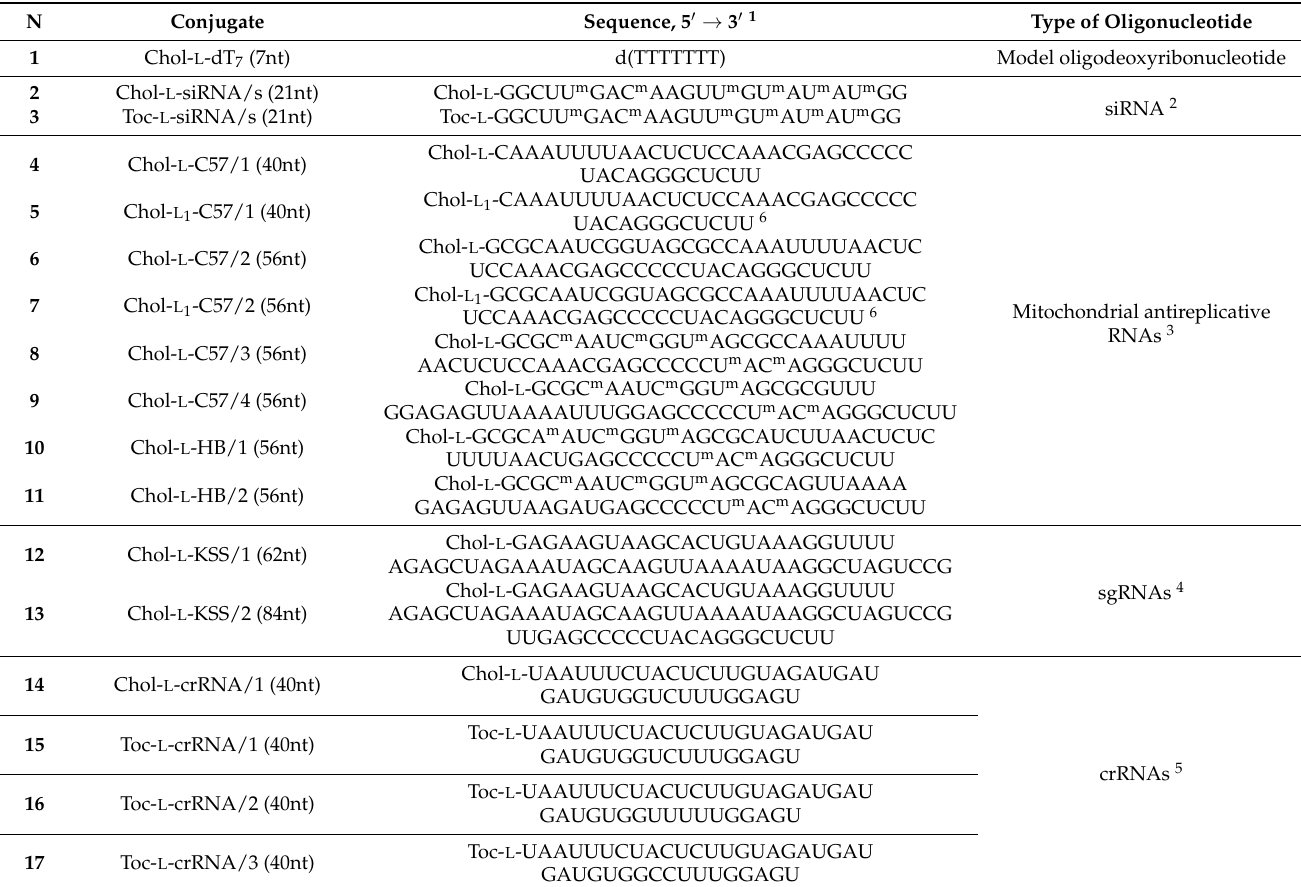
Table 1. Synthesized conjugates of